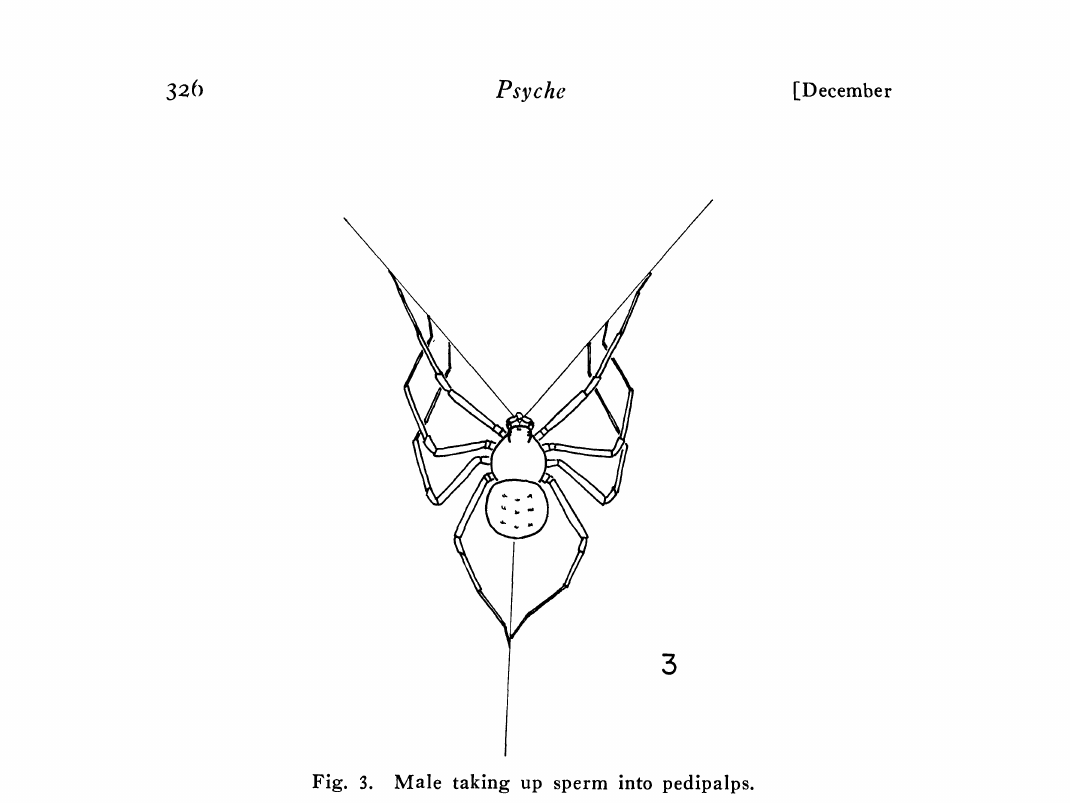
Fig. 3. Male taking up sperm into